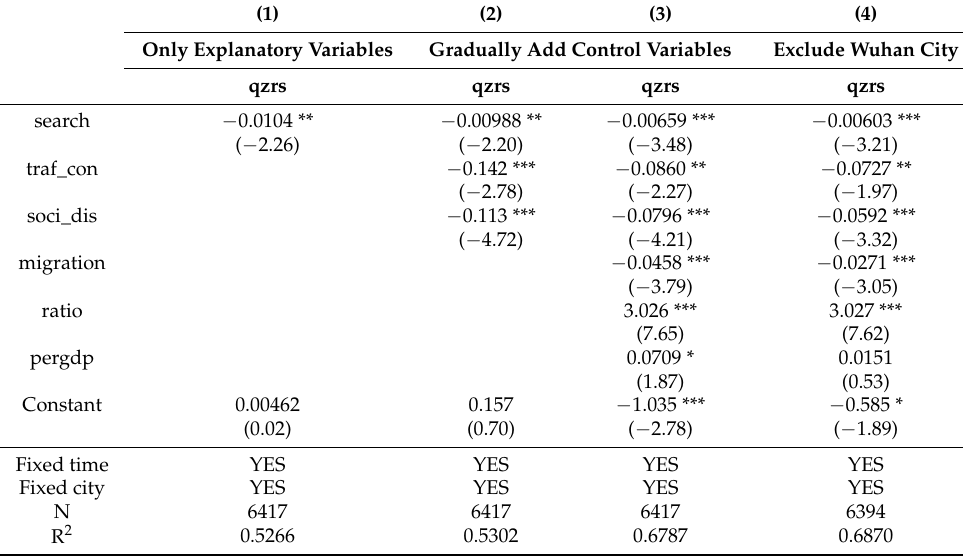
Table 4. Benchmark regression